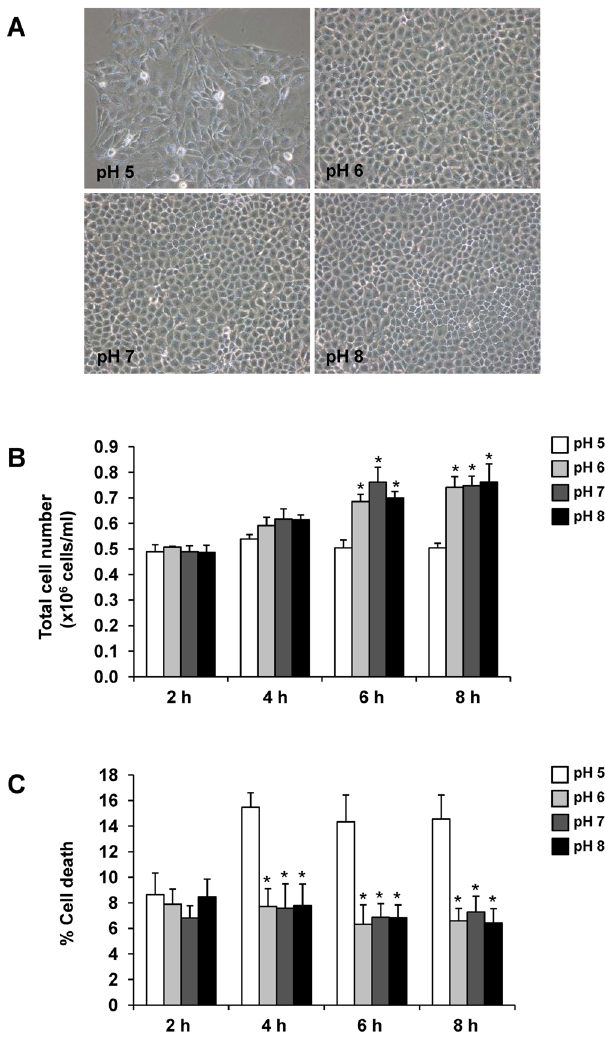
Figure 4. Effect of pH on renal tubular cell proliferation and death. MDCK cells were cultivated and maintained in medium with different pH (from 5.0 to 8.0) for up to 8 h. ( A ) Cell morphology observed under a phase contrast microscope at 8 h with original magnification of 200 × . ( B ) Total cell number representing cell proliferation. ( C ) Cell death assay using Trypan blue staining. The data are reported as mean ± SEM of the data obtained from 3 independent experiments. * p < 0.05 vs. pH